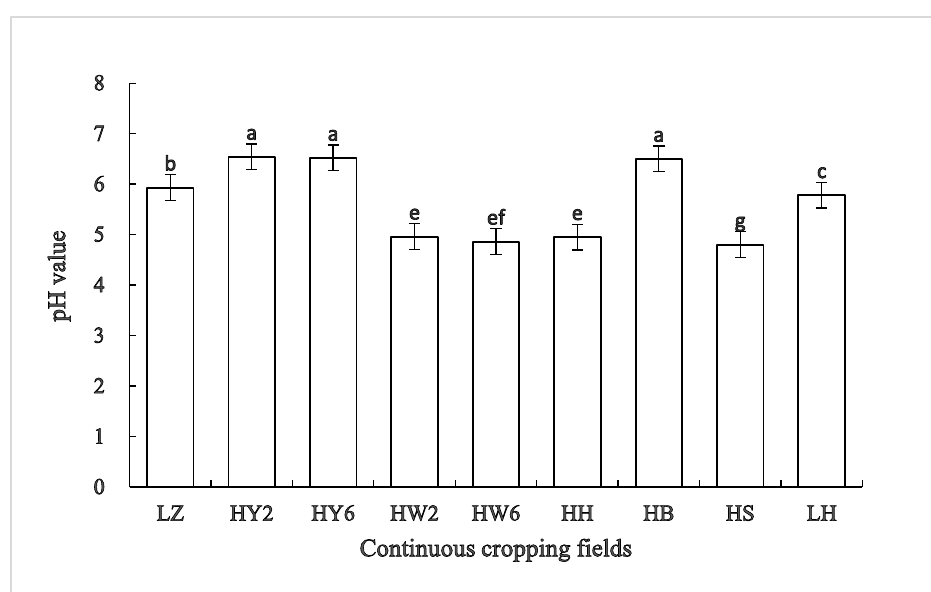
Figure 1. pH value in different continuous cropping fields. LZ, HY2, HY6, HW2, HW6, HH, HB, HS, and LH; continuous cropping of C. chinensis for 5 years, maize continuous cropping for 2 years, maize continuous cropping for 6 years, P. multiflorum continuous cropping for 2 years, P. multiflorum continuous cropping for 6 years, sweet potato continuous cropping for 2 years, F. thun ‐ bergia continuous cropping for 2 years, cabbage continuous cropping for 2 years, and fallow field, respectively. Different letters indicate significant differences between the fields ( p ‐ Value < 0.05).